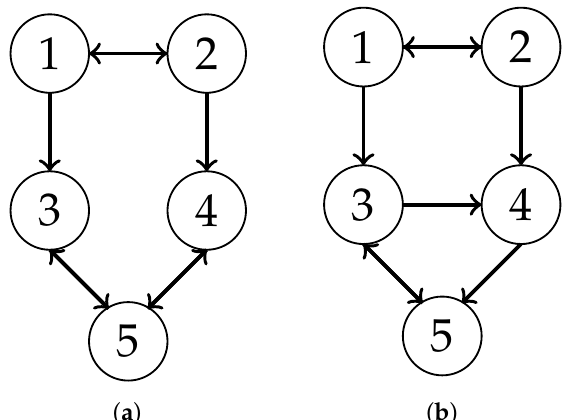
Figure 3. The double independent position–velocity communication graph: ( a ) the position commu- nication graph, ( b ) the velocity communication graph.